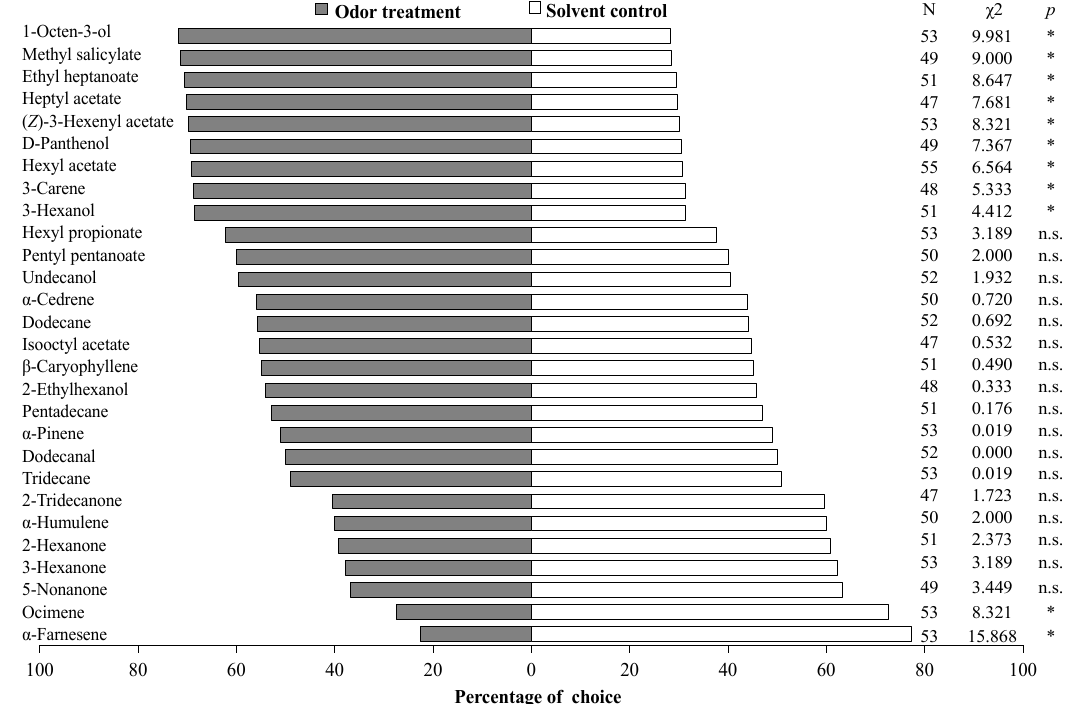
Figure 4. Responses of female Sitodiplosis mosellana adults to synthetic odors derived from wheat volatiles. All tested compounds subjected to Y-tube olfactometer assays were diluted with liquid para ffi n to a final concentration of 20 µ g / µ L and liquid para ffi n was used as the solvent control. N marks the number of individuals that made a choice out of 60 tested insects, and the insects that did not make a choice are excluded from the statistical analysis. Asterisk denotes significant di ff erence ( p < 0.05), and n.s. indicates no significant di ff erence by chi-square tests.